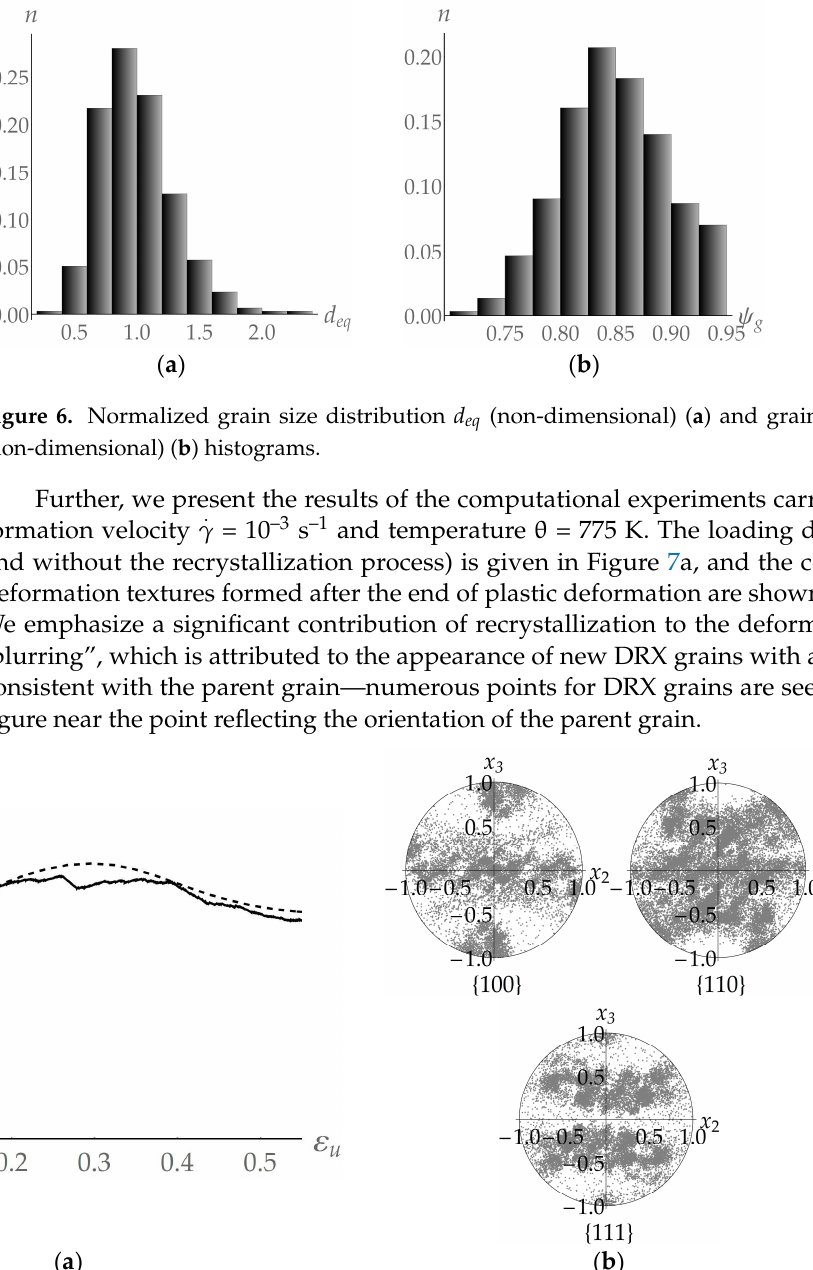
Figure 7. Loading diagram for the copper polycrystal at deformation velocity γ = 10 –3 s –1 and temperature θ = 775 К (dashed curve—experiment [78], solid curve—calculations) ( a ). Calculated pole figures {100}, {110}, and {111} at the end of deformation ( b ).